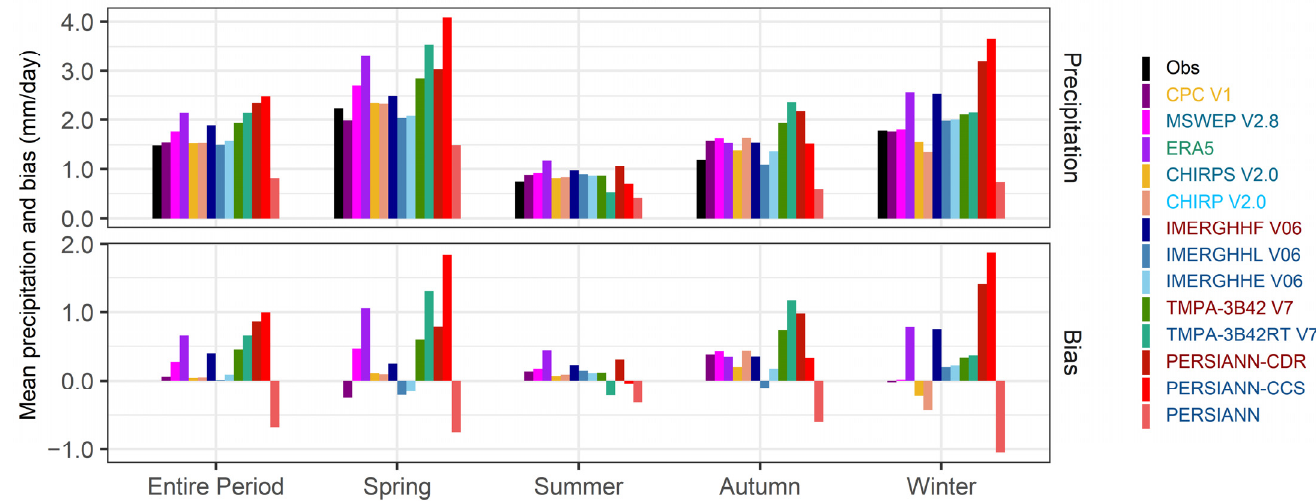
Figure 3. Mean daily precipitation and estimated bias for the entire period and four seasons. The color of legend text present: observed (black), satellite-based (blue), gauge and satellite (red), reanalysis and satellite (sky blue), reanalysis (green), reanalysis, ground, and satellite (steel blue), and ground (yellow).